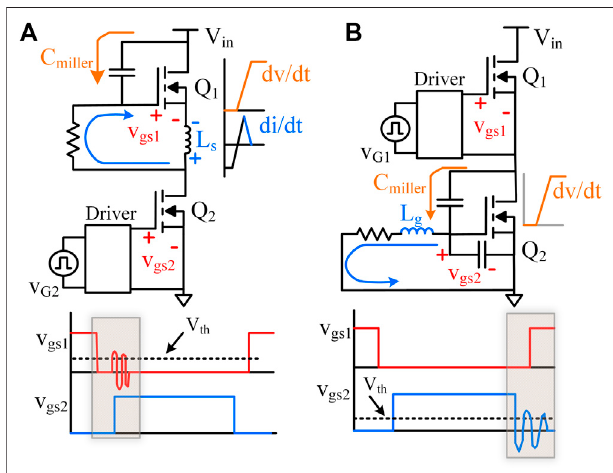
FIGURE 4 | False turn-on due to gate to source voltage oscillation (A) When Q 2 is turned on, high dv/dt appears across Q 1 and fl ow of current through miller capacitor ( C gd ) may false turn-on the Q 1 (B) When Q 2 is turned offandQ 1 isturnedon,high dv/dt appearsacrossQ 2 and fl owofcurrent through miller capacitor ( C gd ) may false turn-on the Q 2 (Wang et al., 2018).